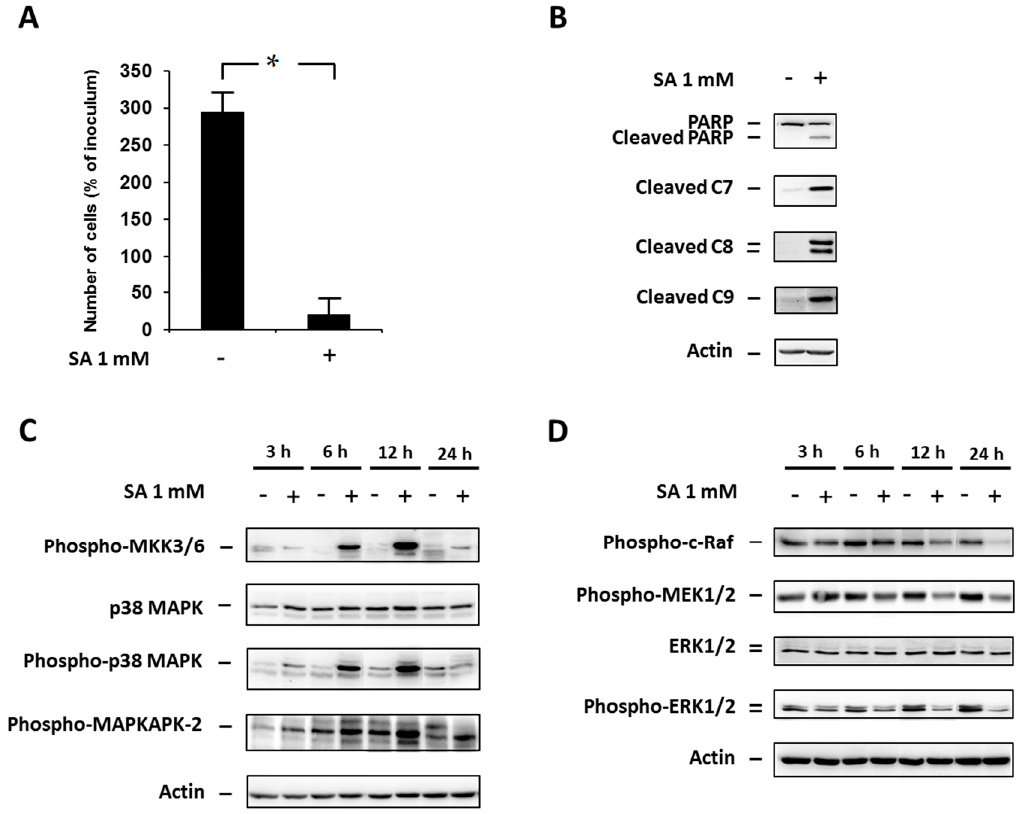
Figure 1. Effect of 1 mM stearic acid (SA) (see “Materials and Methods”) on ( A ) cell growth